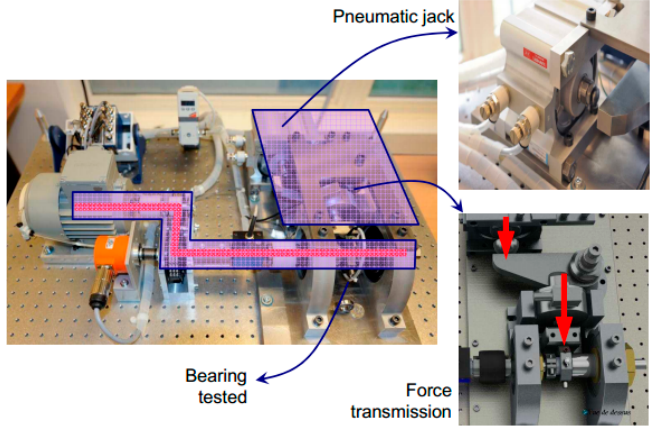
Figure 8. Bearing-accelerated degradation test rig.